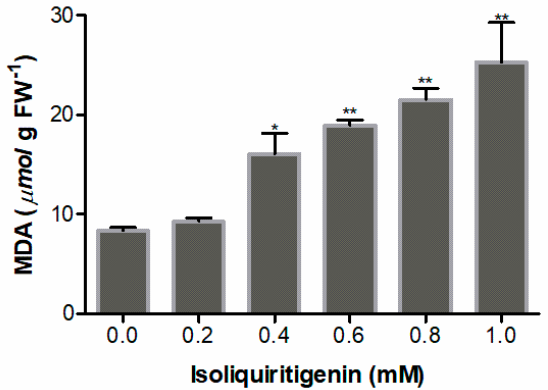
Figure 8. MDA content in lettuce radicles after treatment with different concentrations of isoliquiritigenin. Data presented are the mean ± standard deviation of results from three independent experiments. N = 3. One asterisk * and two asterisks ** represent the significant difference between isoliquiritigenin-treated lettuce radicles and the control at p < 0.05 and p < 0.01, respectively.